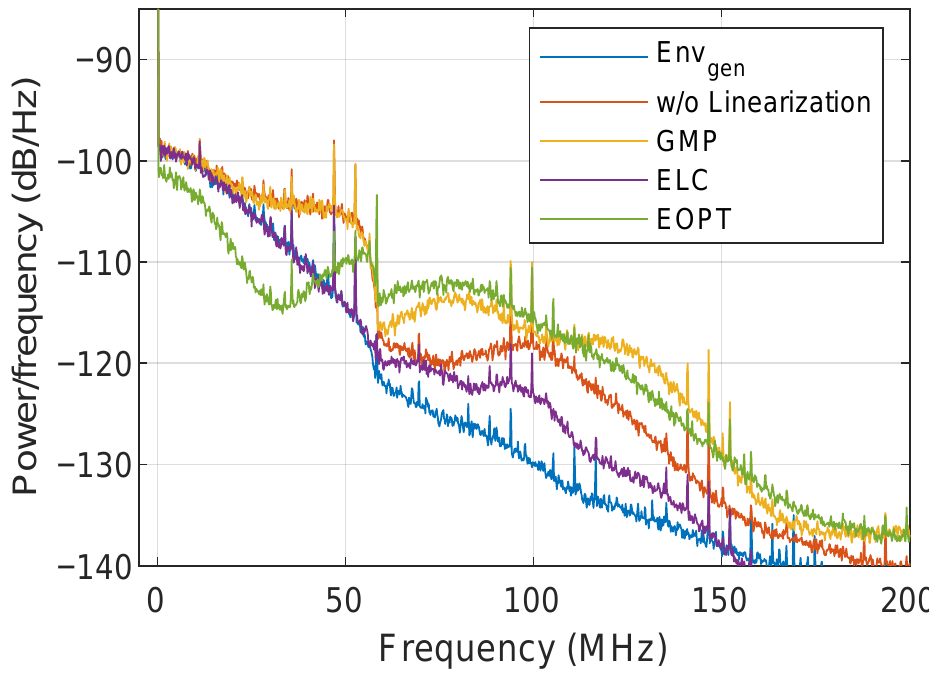
Figure 13. Spectra of different supply envelopes without and with different linearization